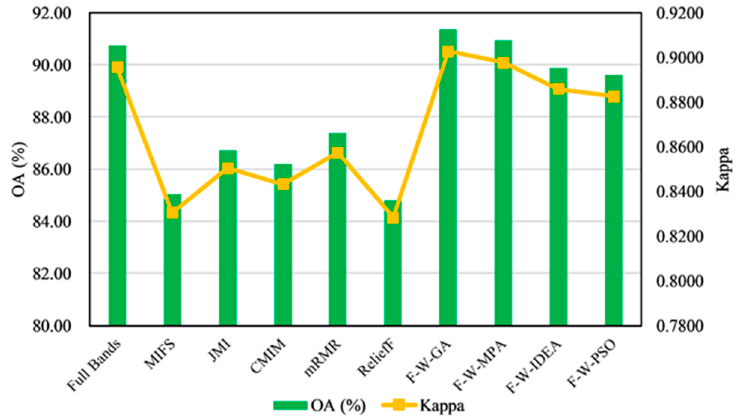
Figure 10. The average OA (%) and Kappa of these algorithms on the three HSIs.